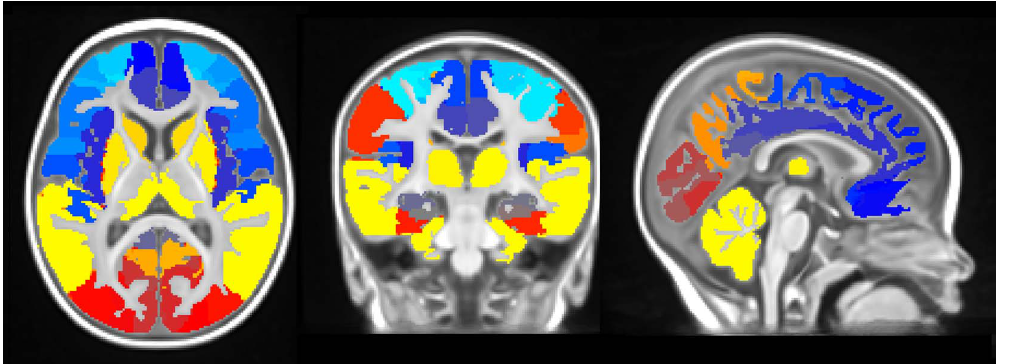
Figure 5. Six-month-old infant atlas. The color overlay of the AAL, which has been carefully modified to fit the average 6-month-old head morphometry, is superimposed on the 6-month-old average template. Sagittal, coronal and axial slices are shown at (97, 116, 79).